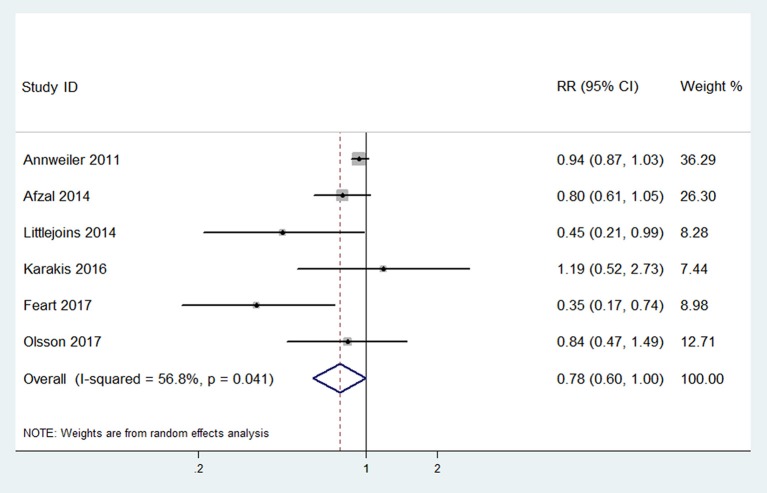
Forest plot of the highest vs. lowest meta-analysis of 25(OH)D level and the risk of Alzheimer's disease.